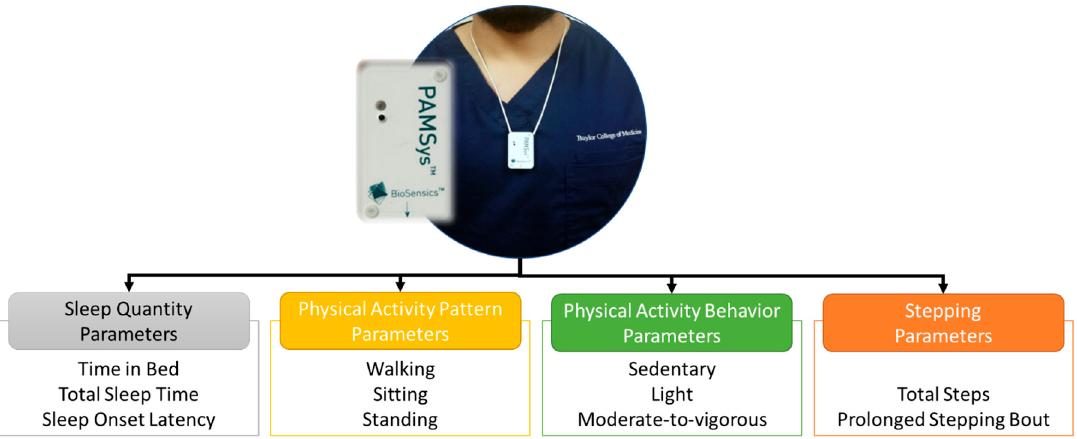
Figure 1. The sensor placement (above) and the common parameters (below) that were extracted, based on validated algorithm, namely: sleep quantity, physical activity patterns, physical activity behaviors, and stepping count.